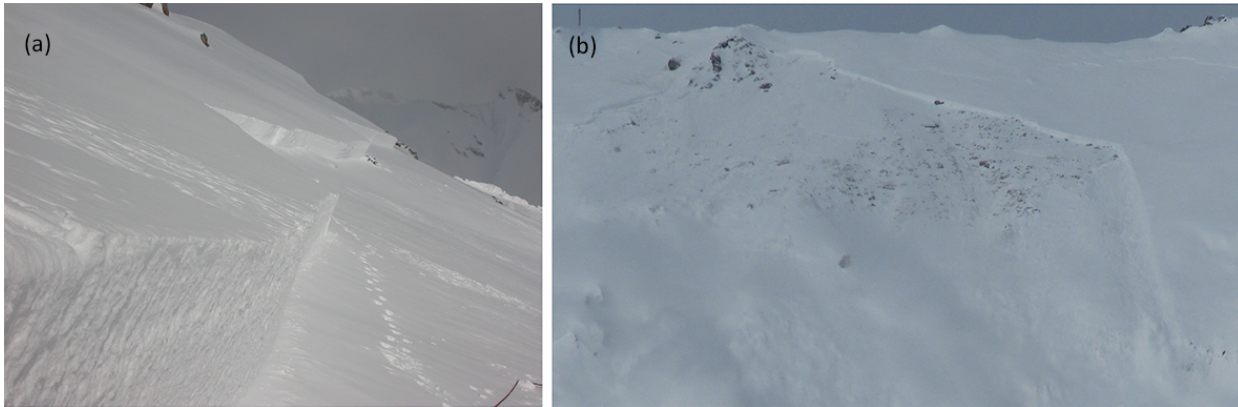
Figure 8. Images of the artificially triggered avalanches at the CB2 basin on (a) 8 March 2006 (avalanche no. 817) and (b) 3 February 2015 (avalanche no.